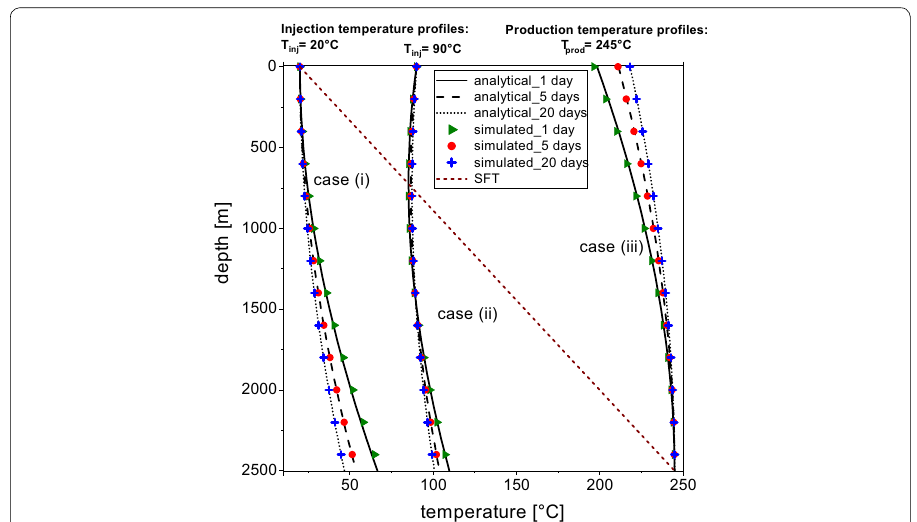
Fig. 8 Comparison of analytical and simulated solution of Ramey’s heat transmission model: case (i) and case (ii) are the injection scenarios, where injection temperatures at well-head are 20 °C and 90 °C, respectively; case (iii) is the production scenario: fluid is produced from bottom-hole at 245 °C reservoir temperature. The analytical solution was plotted in lines: solid lines (one day), dash-dot lines (5 days), dot lines (20 days). The simulated solution was marked in symbols: green crosses (one day), red circle (5 days), diamonds with lower half black (20